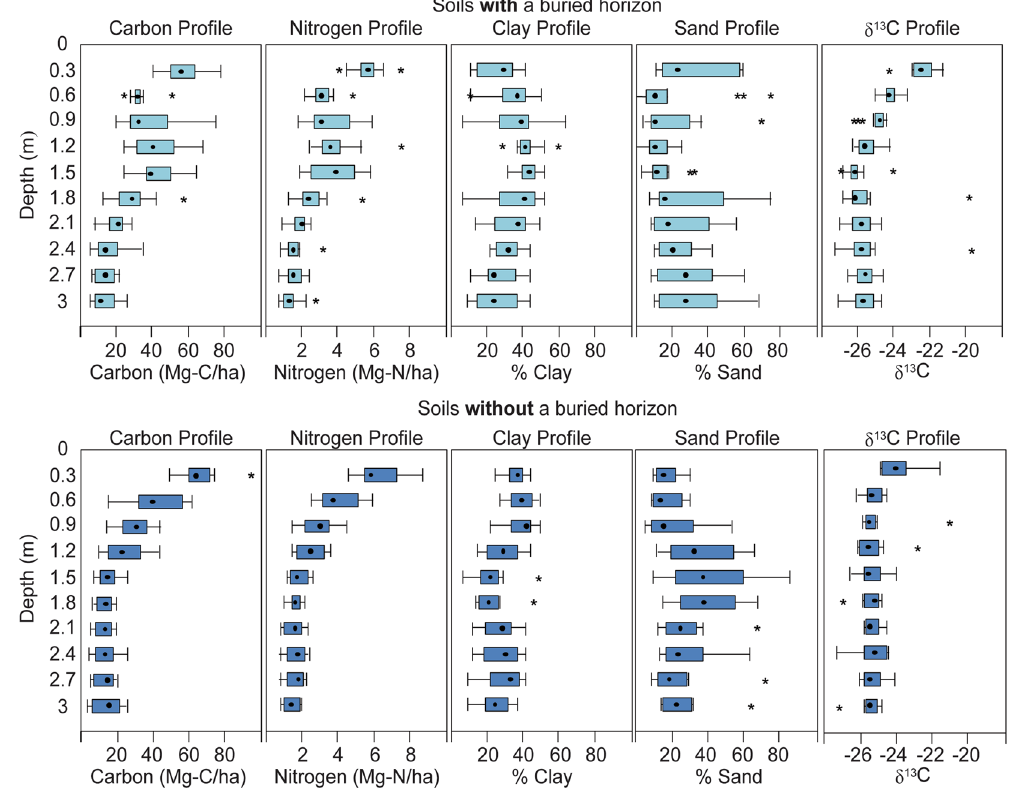
Figure 2. Depth profiles of C, N, clay, and sand contents, and δ 13 C for the soils with a buried horizon and those without. Asterisks indicate outliers, whiskers indicate max and min values, boxes represent the 25% and 75% quantiles, and the bolded dot is the